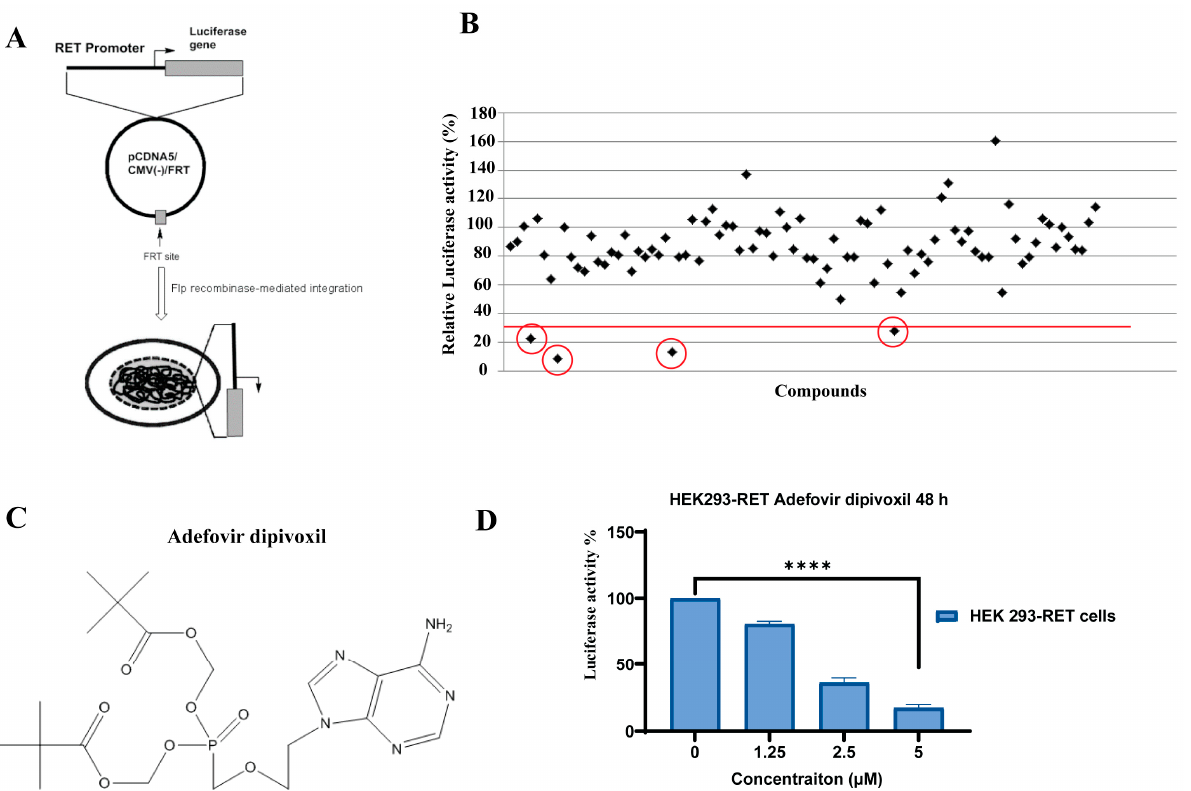
Figure 1. The cell-based screening of the Sellechem FDA approved drug library using the HEK293- RET cells involves the identification of potential drug candidates. ( A ) Scheme for the generation of Flp-In cell line HEK293-RET cell line using the Flp-In expression vector pCDNA5/CMV(-)/FRT/RET; ( B ) Right panel effects of individual compounds (5 μ M) from a single 96-well plate on the luciferase activity in HEK293-RET cells to screen for a potential transcriptional repressor for RET gene. ( C ) Structure of adefovir dipivoxil. ( D ) Validation of the initial hits from the screening assay by performing individual experiment at various concentrations of adefovir dipivoxil up to 48 h. Luciferase activity was measured as relative luminescence units (RLU) and normalized to total protein content. Experiments were performed in triplicate with normalized quantification and analysis of the difference between concentration by Student’s t -test ( n = 3; **** p ≤